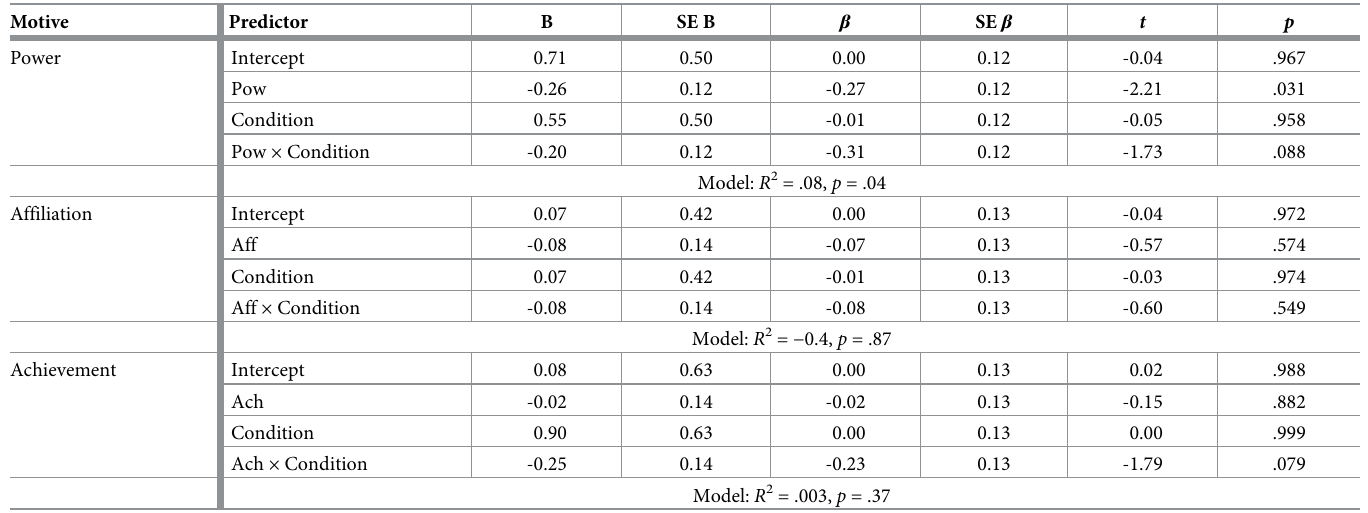
Table 1. Moderated regression analyses of participants’ variable error for each of the three motives.